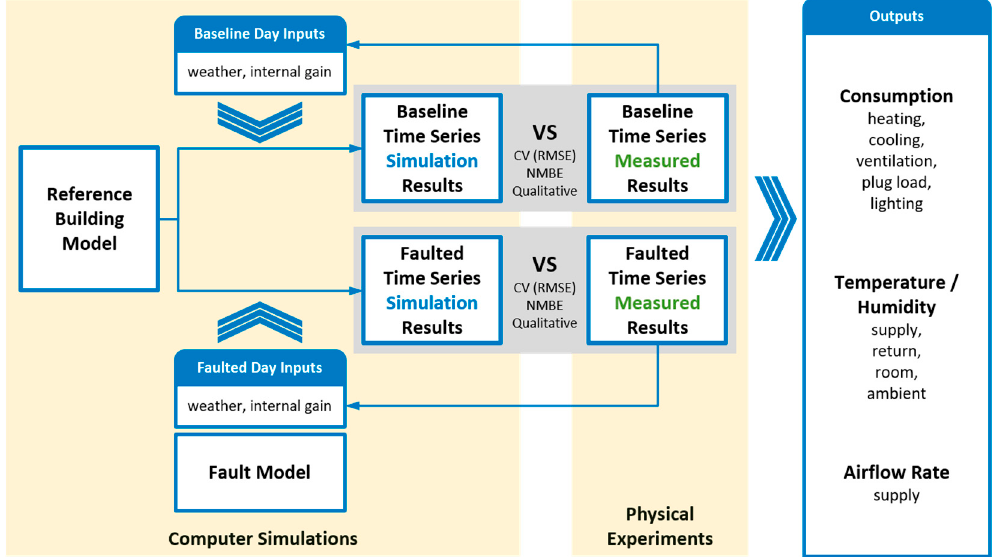
Figure 3. Fault model validation workflow via the Parametric Analysis Tool.